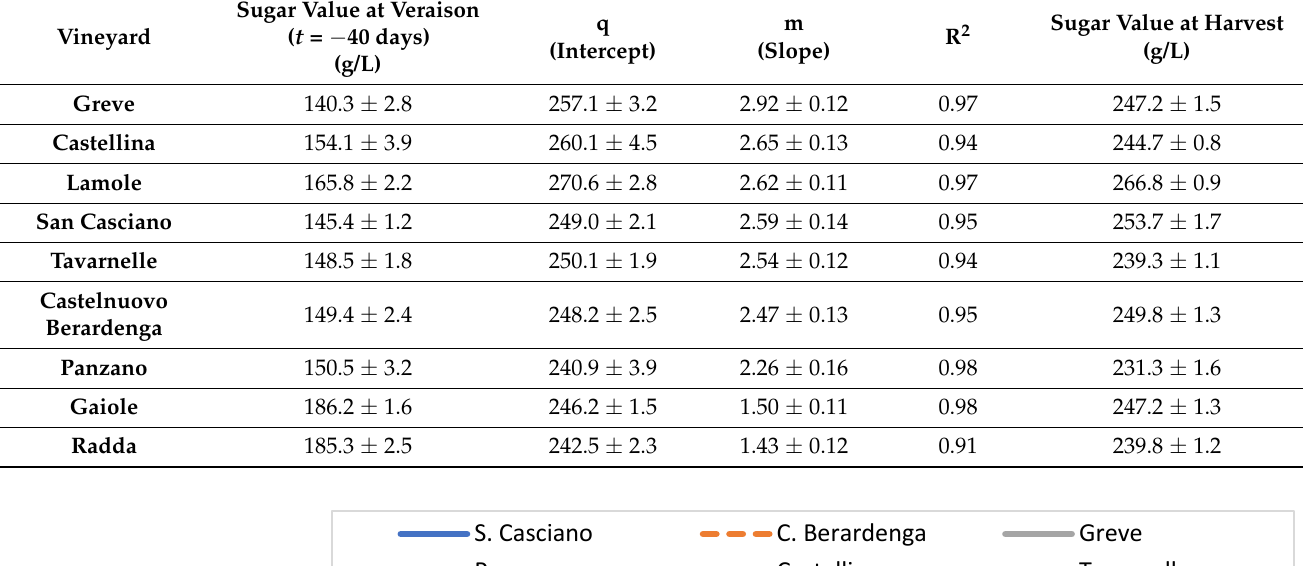
Table 5. Calculated values of the functional parameters, intercept, slope and R 2 of the sugar values inside the grapes coming from the different vineyards.